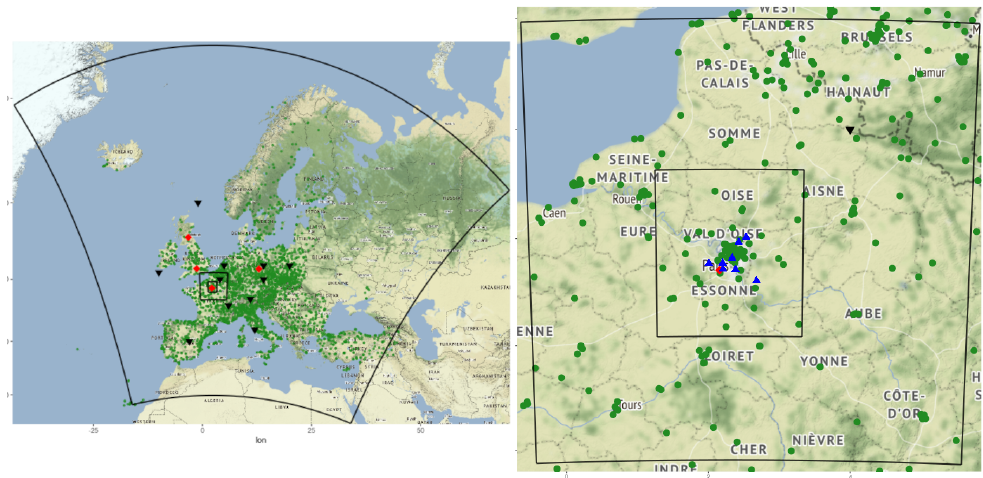
Figure 1. The simulations are run on a triple-nested configuration with a European domain with a 30km resolution (FAIR30), an intermediary domain with a 10 km resolution (PAR10) and the finest domain focused on the Parisian region with roughly 3 km resolution (PAR03). Green circles are the EEA stations, red diamonds represent EBAS stations for NH + /NO − measurements, black downward 3 4 triangles show WOUDC OzoneSonde stations and blue triangles show météo-France stations used in this study. Ozone Sonde stations are not located in the two inner domains. Data were extracted from the E-OBS gridded fields by using the locations of EEA stations; therefore, stations for both are similar (green